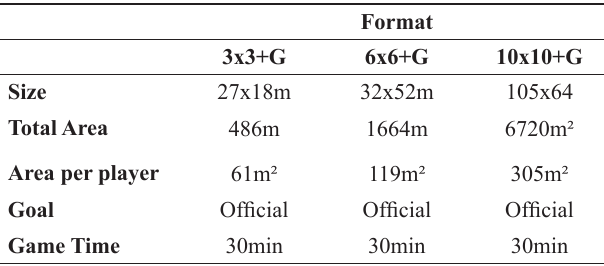
Table 2. Format of the fields where the games took